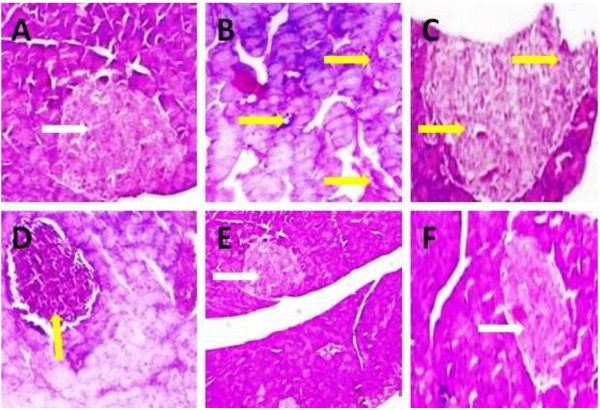
Effect of umbelliferone β-D-galactopyranoside (UFG) photomicrographs of histological changes in rat pancreas: (A) Normal control: Histological structure of normal control group rat pancreas showing the normal islet (white arrow) (B) Diabetic control: Focal necrosis (yellow arrow) showed in the histopathology of diabetic control group rat. (C) UFG I (10 mg/kg): Treatment Histopathology of tested drug rat showing bigger size of islet and focal necrosis (yellow arrow) (D) UFG II (20 mg/kg): Histopathology of tested drug rat showing focal necrosis (yellow arrow) (E) UFG III (40 mg/kg): Histopathology of tested drug rat showing normal size of islet (white arrow) (F) Glibenclamide (10 mg/kg): glibenclamide treated rat pancreas showing normal islet (white arrow). For each group 6 rats were examined and 80 pictures were taken. The above picture for each group was chosen randomly from the 80 pictures in this group. Original magnification, 10 × .